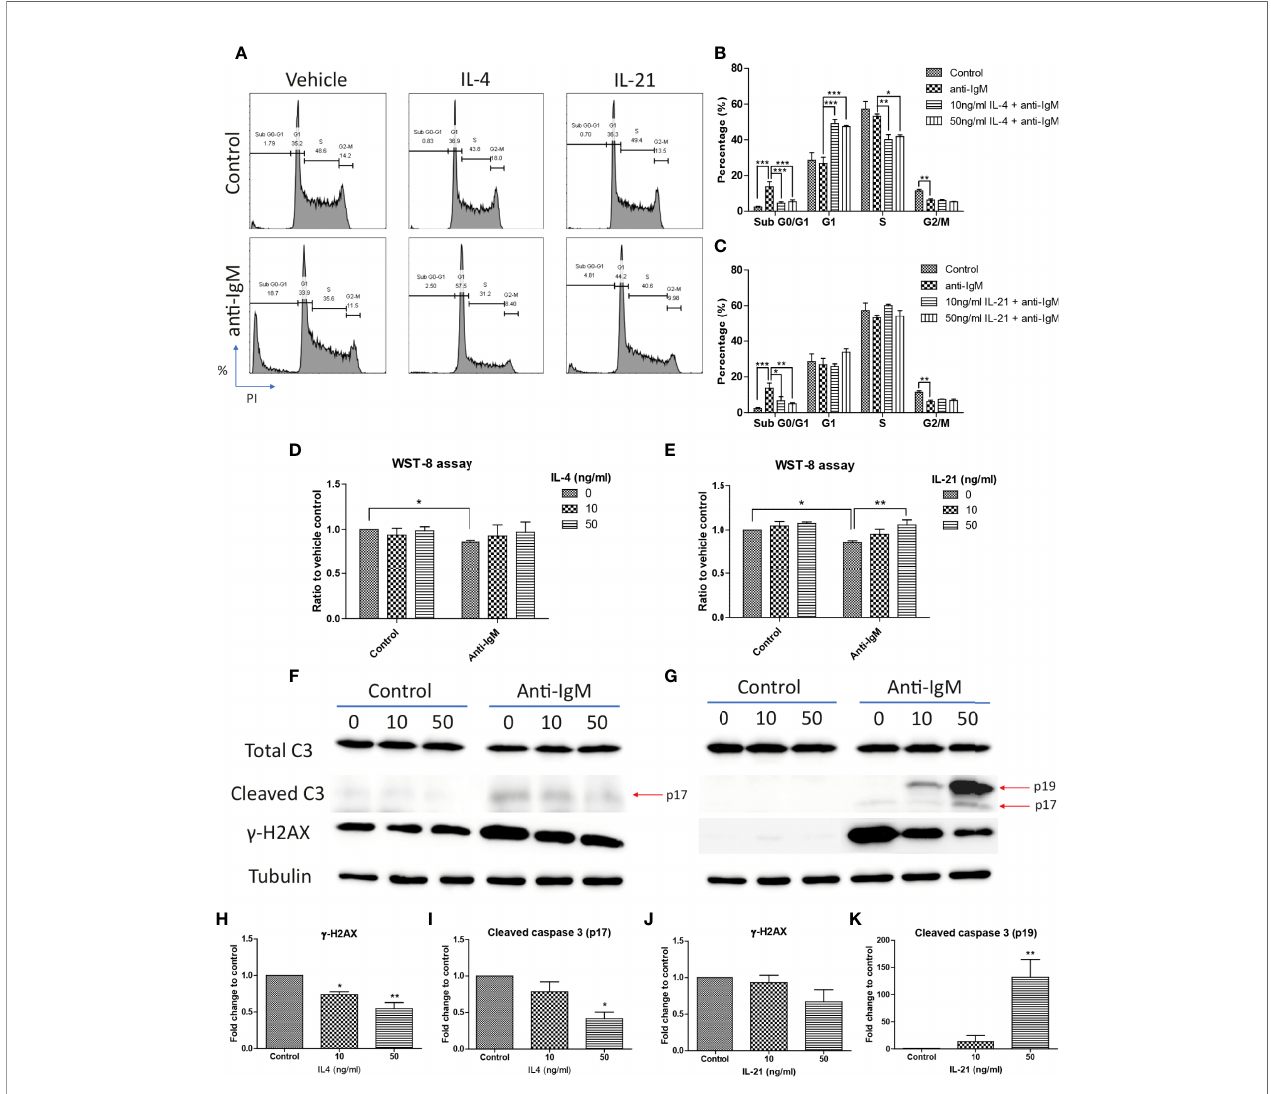
FIGURE 4 | IL-4 and IL-21 rescued anti-IgM induced apoptosis by differential mechanisms. (A) Representative images showed that anti-IgM (2 µg/m) shifted cells from S and G2-M phases to sub G0/G1 phase, and the application of IL-4 and IL-21 reversed this de fi cit. Quanti fi cation showed that (B) IL-4 shifted the cells from sub G0/G1 to G1 phase and (C) IL-21 shifted cells from sub G0/G1 evenly to G1 and S phases. (D, E) WST-8 proliferative assays demonstrated that IL-21 (50 ng/ml) but not IL-4 re-stimulated proliferation after anti-IgM induced cell cycle arrest. (F, G) Representative images showed that IL-4 and IL-21 differentially modulated the levels of anti-IgM induced cleaved caspase 3 and g -H2AX. Quanti fi cation indicated that (H, I) IL-4 signi fi cantly suppressed cleaved caspase 3 and g -H2AX upregulation while (J, K) IL-21 lead to accumulation of intermediate isoform of cleaved caspase 3 and showed a trend to g -H2AX suppression, under anti-IgM condition. For 4B-E, student t-test was used to compare difference between control and anti-IgM groups, while one-way ANOVA was used to determine the effects of IL-4 and IL-21 during anti-IgM treatment. For 4H-K, one-way ANOVA was used to determine the effects of IL-4 and IL-21 on suppression of cleaved caspase 3 and g -H2AX levels as compared to anti-IgM control. *p < 0.05, **p < 0.01, ***p < 0.001. N =